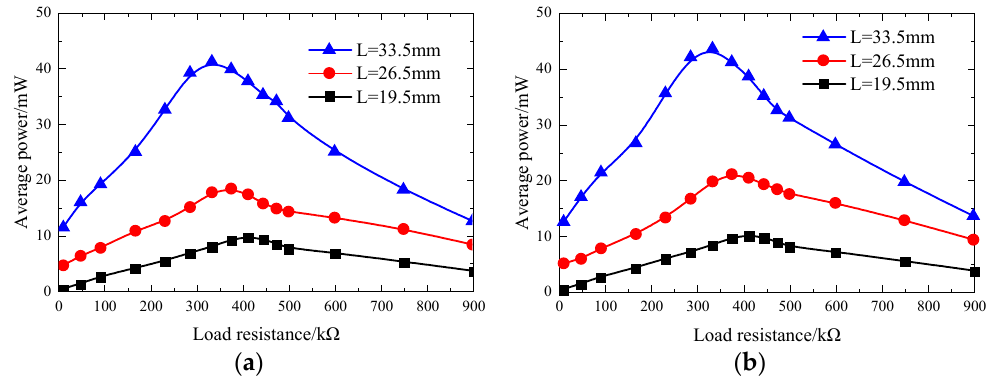
Figure 13. Average powers from unimorph PCSs of 2# piezoelectric brick versus the load resistance and force arm length ( F = 500 N, f = 1 Hz). ( a ) 2#1 PZT4 patch on PCS1; ( b ) 2#3 PZT4 patchon PCS2.